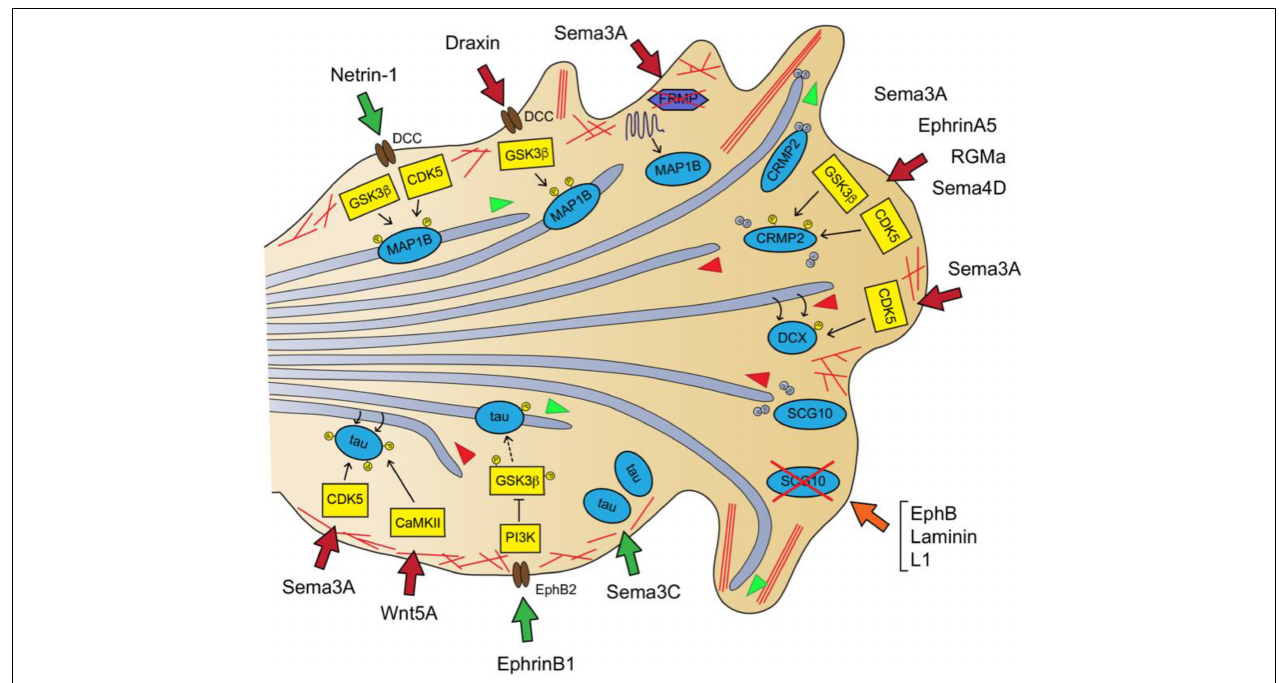
FIGURE 2 | Guidance signaling downstream pathways involved in MT dynamics in the axon and GC I: MT-stabilizing, MT-destabilizing and MT-polymerization supporters. Netrin-1-DCC signaling produces MT stabilization via MAP1B phosphorylation through GSK3 and CDK5 activity (Del Río et al., 2004). Draxin binds DCC receptor and leads to MAP1B phosphorylation via GSK3 β (Meli et al., 2015). Sema3A stimulates MAP1B mRNA local translation by promoting the proteasome-dependent degradation of the repressor FRMP (Takabatake et al., 2020). Sema3A, EphrinA5, RGMa or Sema4D inhibit MT polymerization by increasing CRMP2 phosphorylation via GSK3 β and CDK5 (Arimura et al., 2005; Cole et al., 2006; Ito et al., 2006; Wang et al., 2013). Sema3A promotes MT destabilization by promoting DCX-fall off the MT lattice via CDK5-dependent phosphorylation of DCX (Bott et al., 2020). The combined action of EphB, laminin and L1 leads to MT overgrowth and buckling by reducing SCG10 protein levels (Suh, 2004). Sema3C increases tau protein levels (Moreno-Flores et al., 2004). EphrinB1-EphB2 signaling reduces tau hyperphosphorylation via PI3K-dependent inhibition of GSK3 (Jiang et al., 2015). Wnt5a promotes MT redistribution by stimulating CaMKII-dependent phosphorylation of tau at Ser262 (Li et al., 2014). Sema3A transiently increases tau phosphorylation at Ser202 and Thr205 via CDK5-dependent phosphorylation (Sasaki et al., 2002). MTs are shown as light purple tubes, F-actin as red lines. MAPs are represented in blue, kinases in yellow and MAP-interacting proteins in purple. Guidance cue receptors are in brown. Guidance-evoked responses are represented in green (attraction), red (repulsion) and orange (pause) arrows. MT advance and retraction are represented with green and red arrowheads,